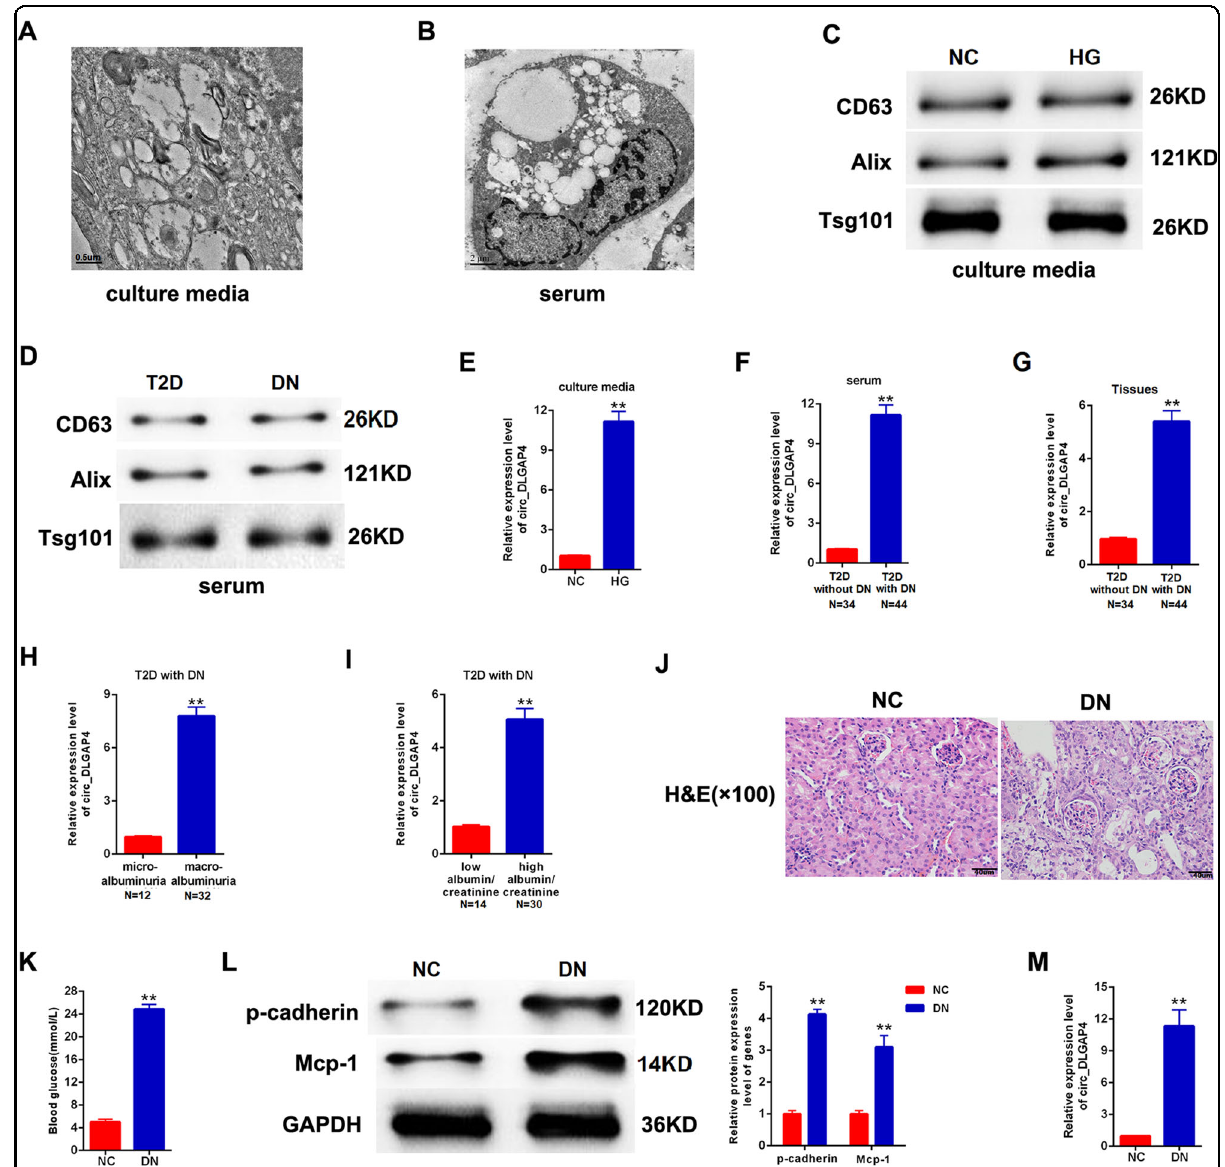
Fig. 1 The expression patterns of exo-circ_DLGAP4 in DKD. A Scanning of exosomes isolated from culture media of MCs using electron microscopy. B Scanning of exosomes isolated from human serum using electron microscopy. C CD63, Alix, and Tsg101 protein expression in culture media of MCs was detected using western blotting analysis. D CD63, Alix, and Tsg101 protein expression in human serum was evaluated using western blotting analysis. E The expression level of circ_DLGAP4 was detected in exosomes isolated from culture media of MCs using qRT-PCR. MCs were treated with NG (5.5 mM) or HG (25 mM) for 24 h. F The expression level of circ_DLGAP4 was tested in exosomes isolated from human serum samples of T2D and DKD patients. G The expression level of circ_DLGAP4 was detected in human serum samples of T2D patients without DKD ( n = 34) or with DKD ( n = 44). H Expression levels of circ_DLGAP4 was detected in DKD with microalbuminuria ( n = 12) or with macroalbuminuria ( n = 32). I The expression level of circ_DLGAP4 were detected in DKD with low eGFR ( n = 14) or high eGFR ( n = 30). J HE staining in NC and DKD rat model. n = 8 in each group. K Blood glucose was detected in NC and DKD rat model. L Western blotting analysis of p-cadherin and Mcp-1 in NC and DKD rat model. M The expression level of circ_DLGAP4 was detected in NC and DKD rat model. Three independent experiments were conducted. Error bars stand for the mean ± SD of at least triplicate experiments; ** P <